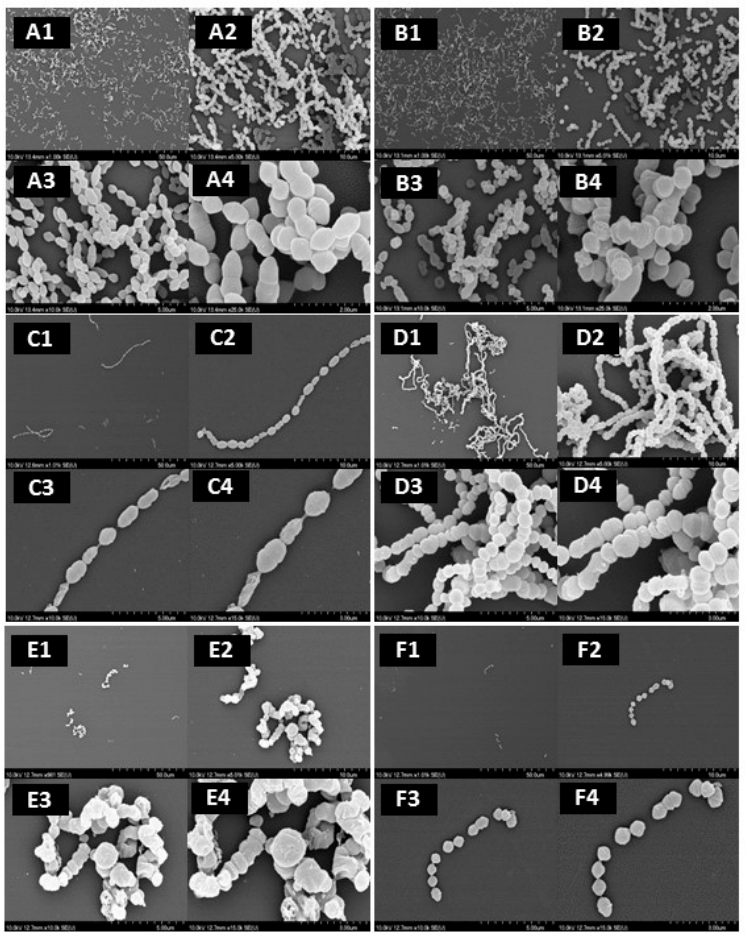
Figure 2. Scanning electron microscopy images of the effect of MBIC concentrations of the compounds on the biofilm formation by strain S. pyogenes ATCC 19615 at 37 °C: S. pyogenes in BHI ( A ) and with 1% DMSO ( B ); S. pyogenes with 25 µg mL − 1 of 1,2 naphthoquinone ( C ); 12.5 µg mL − 1 of 5-hydroxy-1,4 naphthoquinone ( D ); 0.78 µg mL − 1 of dequalinium chloride ( E ) and 25 µg mL − 1 of 4-hexylresorcinol ( F ). Magnification value: I, ×1000; II, ×5000; III, ×1000; IV, ×15,000; V, ×25,000.